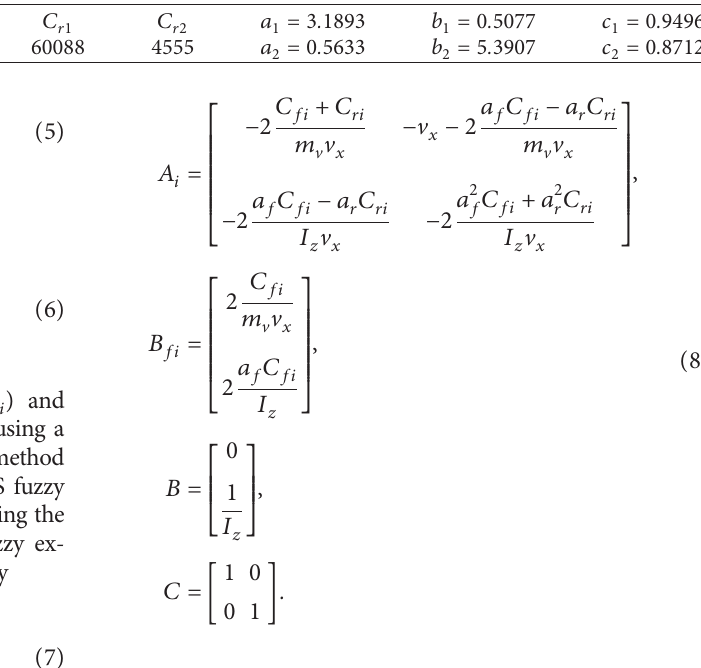
Table 2: Nominal stiffness and membership function